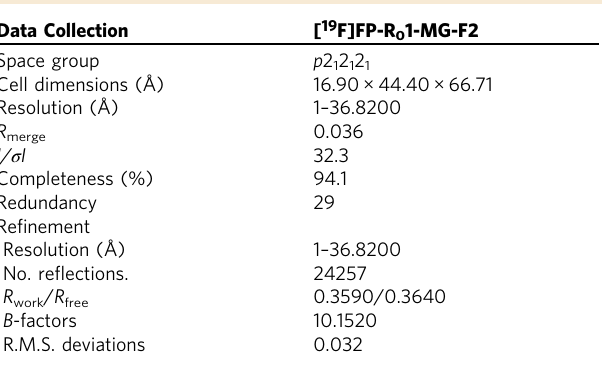
Structural Re fi nement Statistics. The table corresponds to the crystal structure shown in Fig. 1c